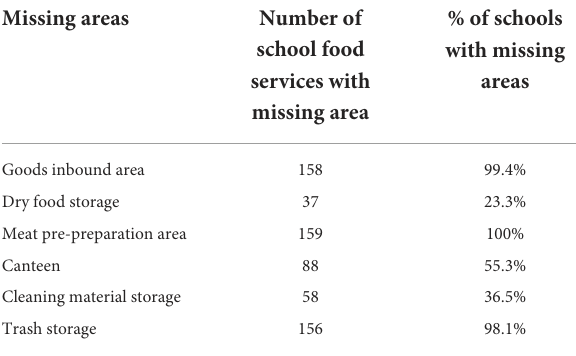
TABLE 2 The compliance of School Food Service facilities of schools in